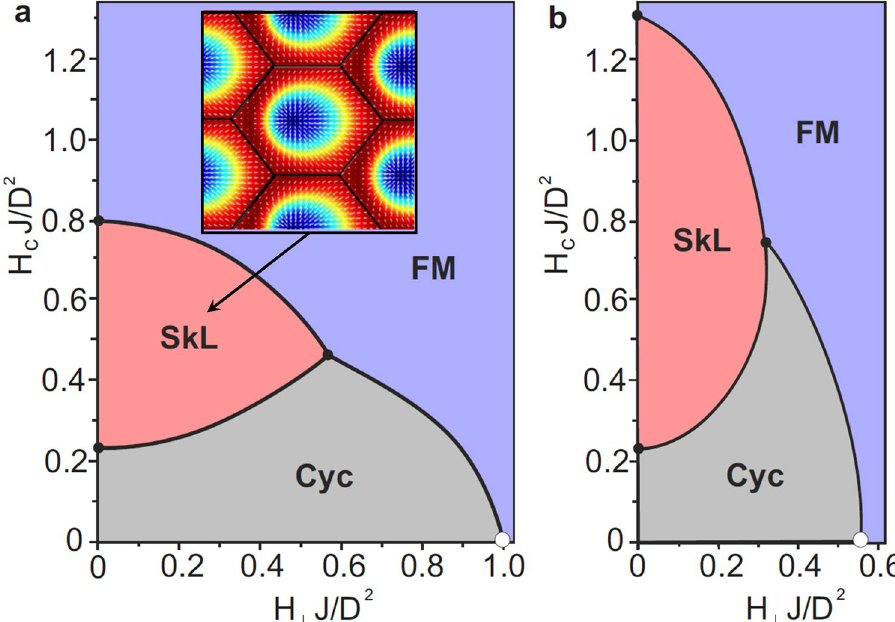
Figure 6. Angular stability of the Néel-type SkL. Stability regions of the cycloidal (Cyc), SkL and ferromagnetic (FM) states on the H c J / D 2 – H ⊥ J / D 2 plane, where H c and H ⊥ are respectively the field components along and perpendicular to the polar c axis, as calculated for ( a ) AJ / D 2 = 0 and ( b ) AJ / D 2 = 0.5. The inset of panel (a) shows the distorted SkL with skyrmion cores displaced horizontally from the center of the unit cell along the H ⊥ field